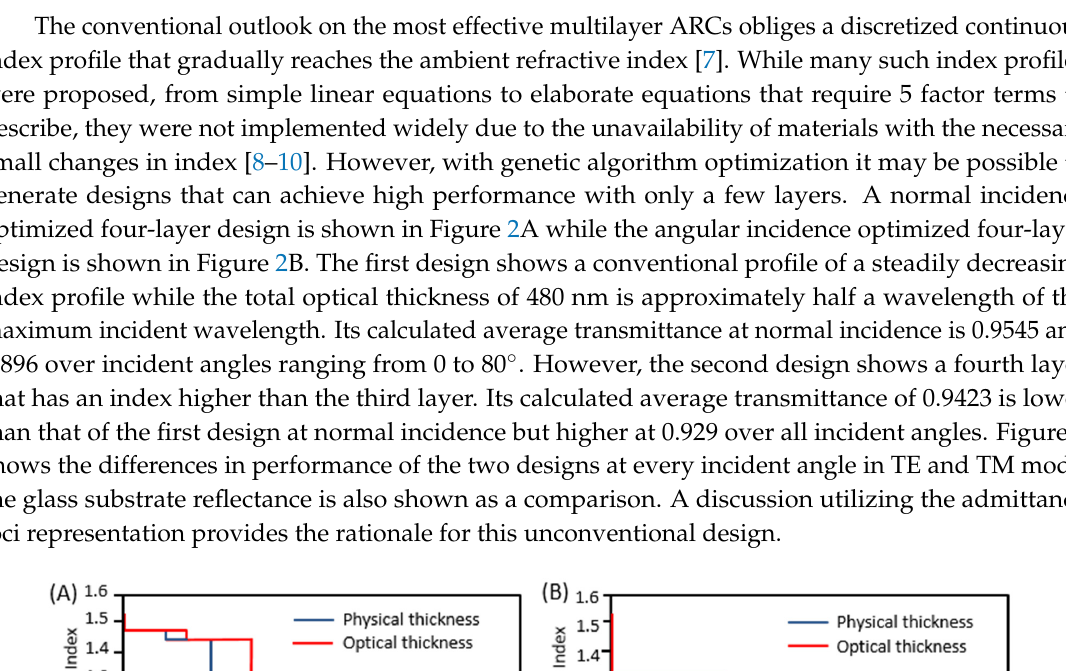
Figure 3. The TE mode and TM mode reflectance profiles of both anti ‐ reflection coating (ARC) designs. The angular incidence optimized design has significantly lower reflectance than the normal incidence optimized design at 70° and 80° incidence. 3.2. Admittance Loci Visualization Figure 4 shows the admittance loci representations of the four ‐ layer designs in TE mode (for the TM mode the visualization is given in Appendix A) and at 500 nm, 700 nm and 900 nm incident wavelengths. The blue arc indicates the first layer starting from the surface of the substrate with a real index 1.54, green the second layer, red the third layer and black the fourth layer. The solid arc indicates an admittance profile at an incident wavelength of 500 nm, the dashed arc at 700 nm, the dash ‐ dot arc at 900 nm. The white circles indicate iso ‐ reflectance circles with center (1,0) of 0.1% (solid), 0.2% (dashed), 1% (dot ‐ dashed) reflectances. The iso ‐ reflectance circles enlarge with increasing incident angles. The iso ‐ reflectance contours in the 70° and 80° loci diagram for the normal incidence optimized ARC indicates 1%, 2% and 5%, and 15%, 20% and 25% reflectance, respectively, and iso ‐ reflectance contours in the 80° loci diagram for the angular incidence optimized ARC are 15%, 20% and 25%.